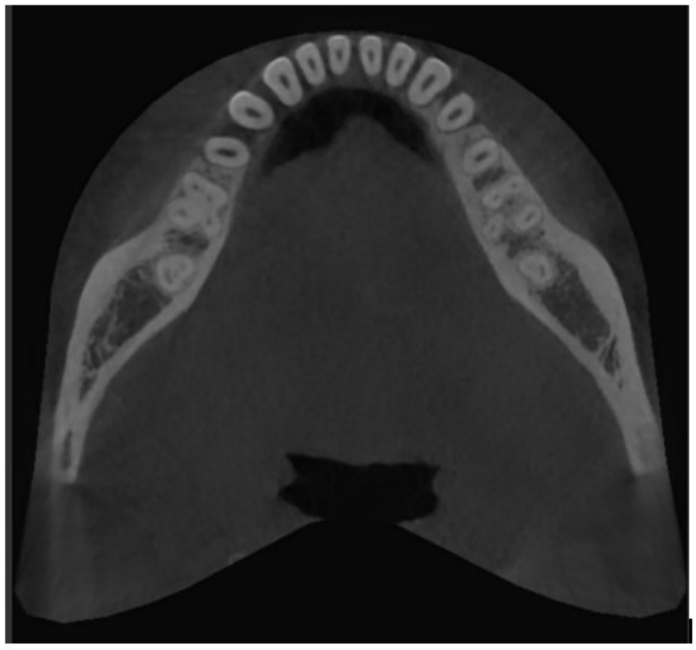
Fig. 6a - CBCT axial view - bilateral occurrence of C - shaped canals in teeth no 37 (C2), 47 (C2) and bilateral occurrence of radices entomolaris in teeth no. 36, 46.